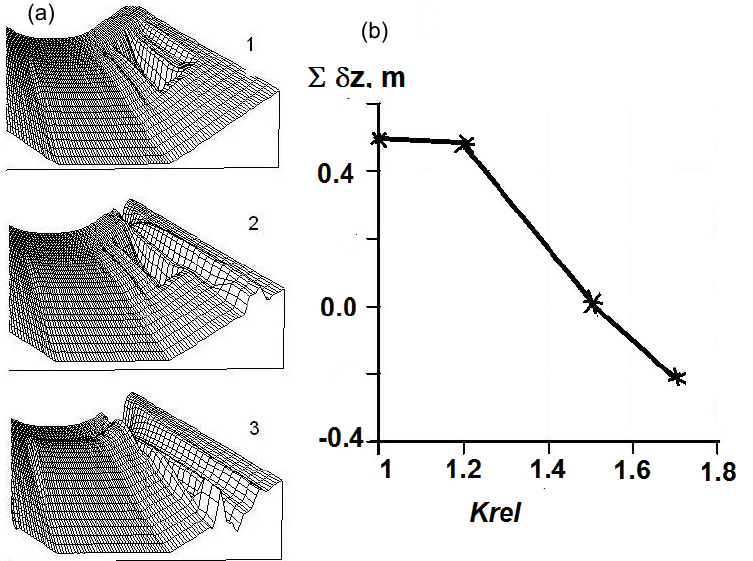
Fig. 5 The topography of the coastal slope formed after 40 minutes of the simulated time after the start of the experiment ((1) at Krel = 1; (2) at Krel = 1.2; (3) Krel = 1.5) (a), the dependence of sum of deviations of the bed surface from parameters of releases Krel.